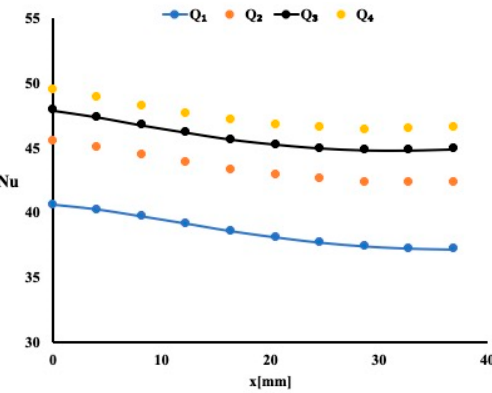
Figure 4. Local Nusselt number variation for different flow rates.